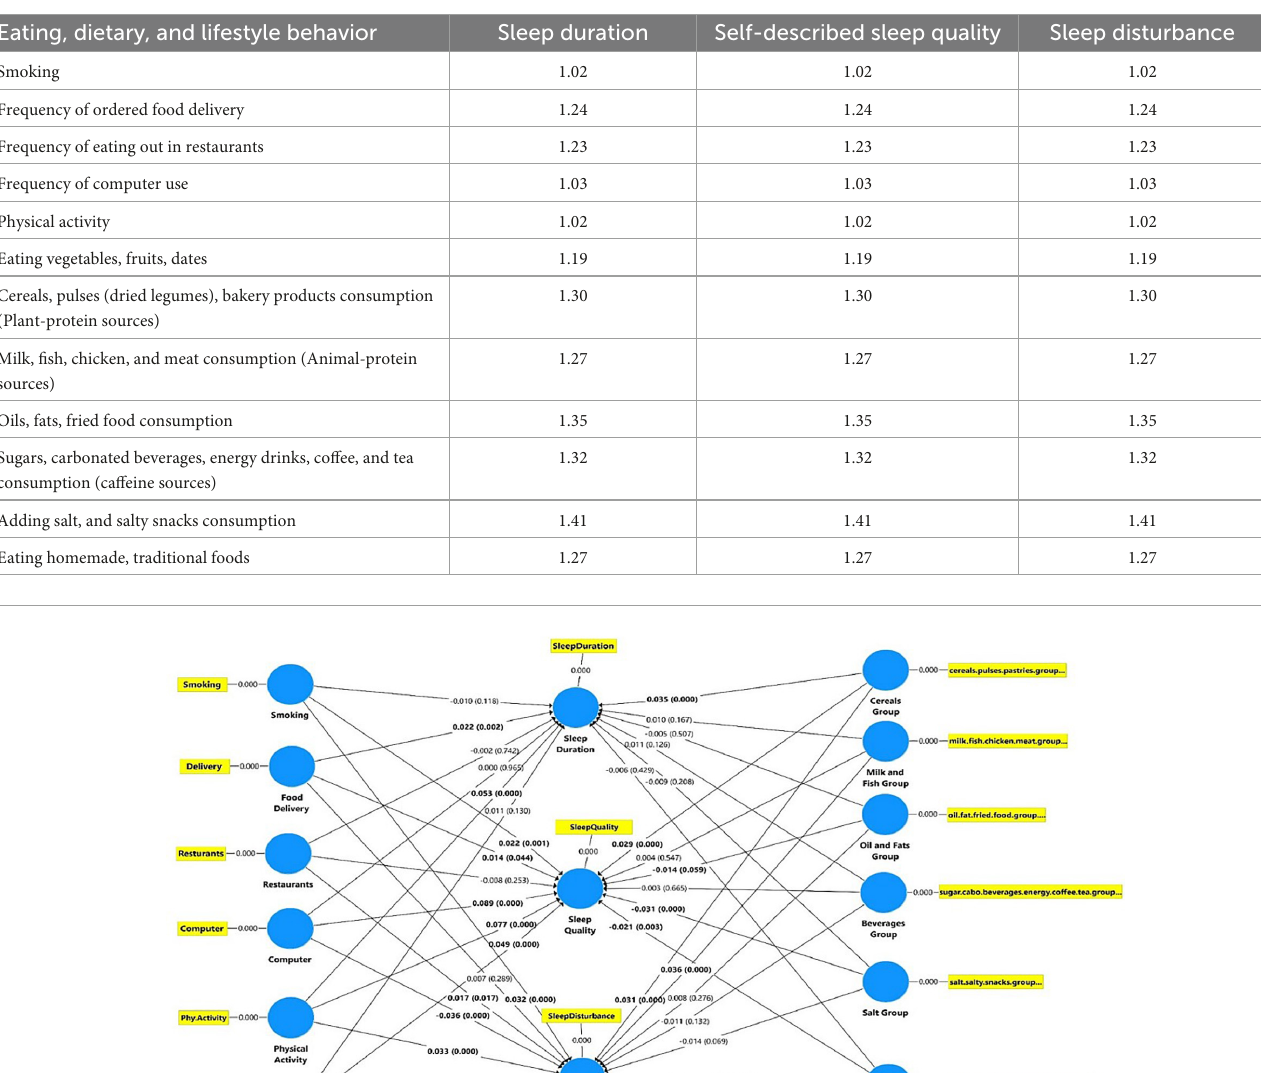
TABLE 2 Collinearity statistics (variance inflation factors) for the study variables ( N = 24,541). Eating, dietary, and lifestyle behavior Sleep duration Self-described sleep quality Sleep disturbance